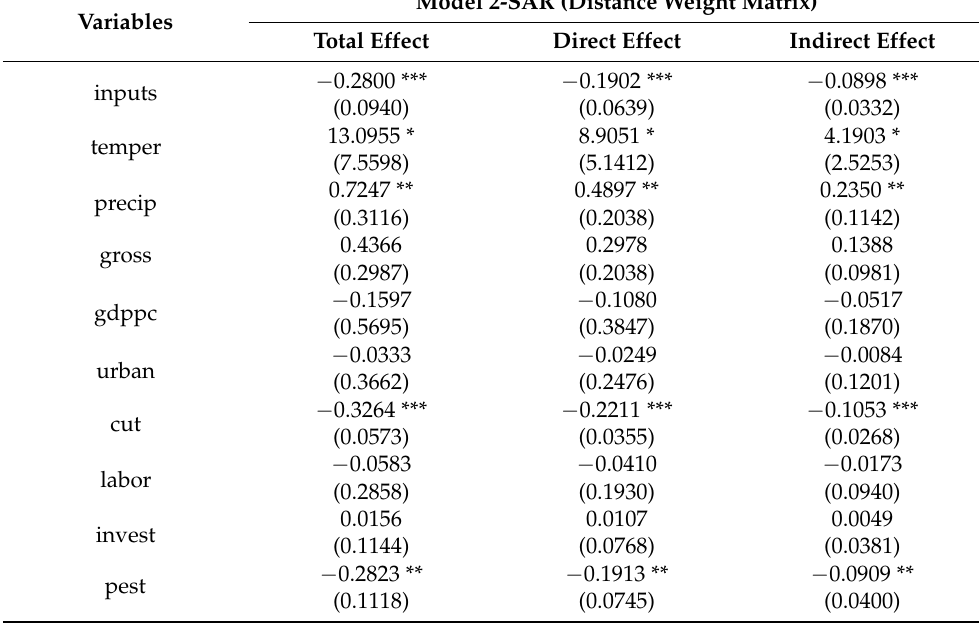
Table 4. Effect decomposition